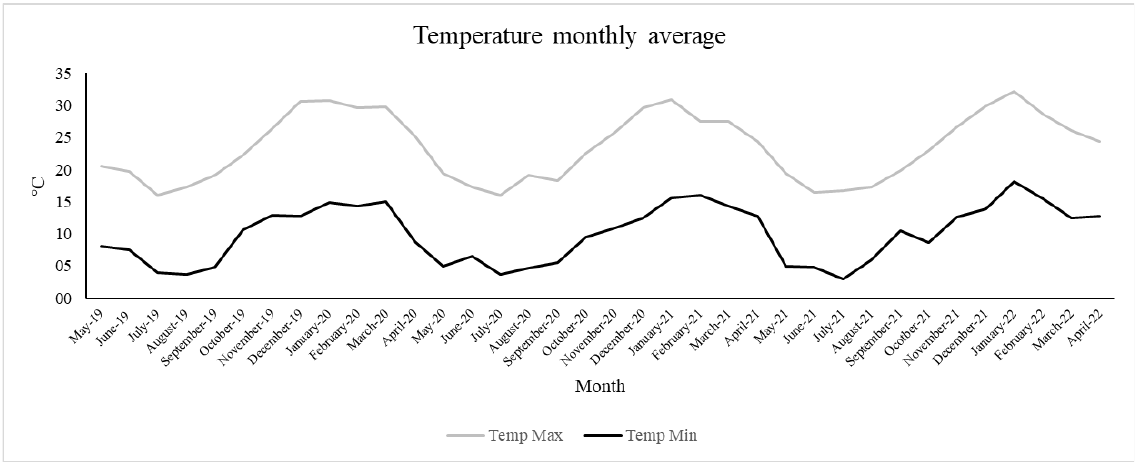
Figure 3. Evolution of monthly average maximum (T max) and minimum (T min) temperatures (°C) between May 2019 and April 2022 in the ‘Palo a Pique’ pasture – crop rotations long-term experiment in Treinta y Tres, Uruguay.